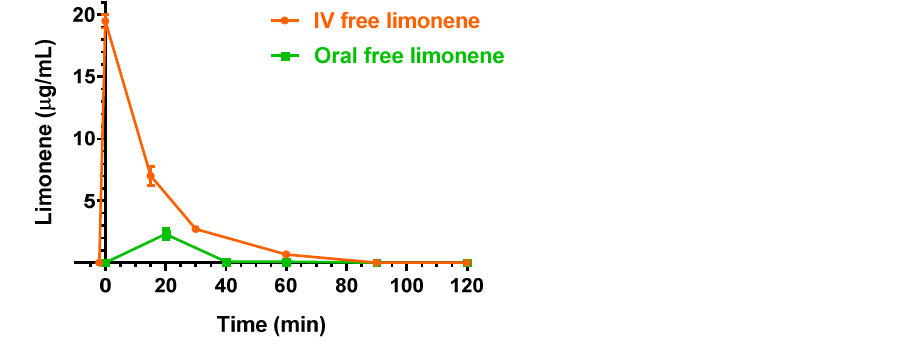
Figure 9. Blood D-limonene concentrations ( µ g/mL) within 120 min after intravenous (IV) and oral administration in the free form of 100 mg/kg and 200 mg/kg doses, respectively, to rats. Data are expressed as the mean ± SE of four independent experiments.